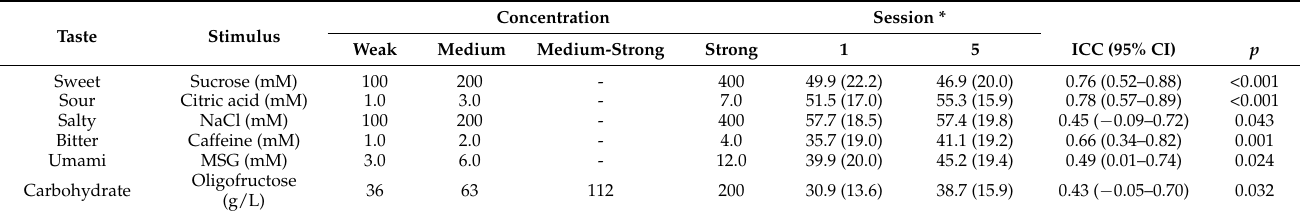
Table 1. Suprathreshold concentrations, mean intensity ratings and intraclass correlation coefficients (ICC) for salty, sweet, sour, bitter, umami and carbohydrate tastes.